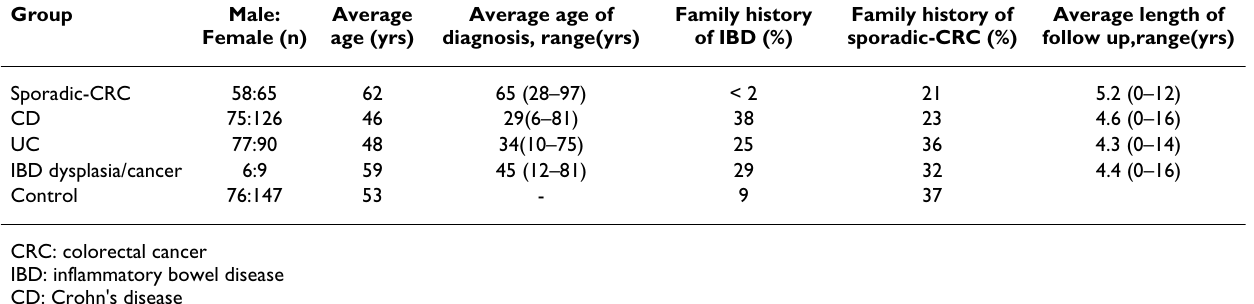
Table 1: Clinical and demographic characteristics of cases and controls. Group